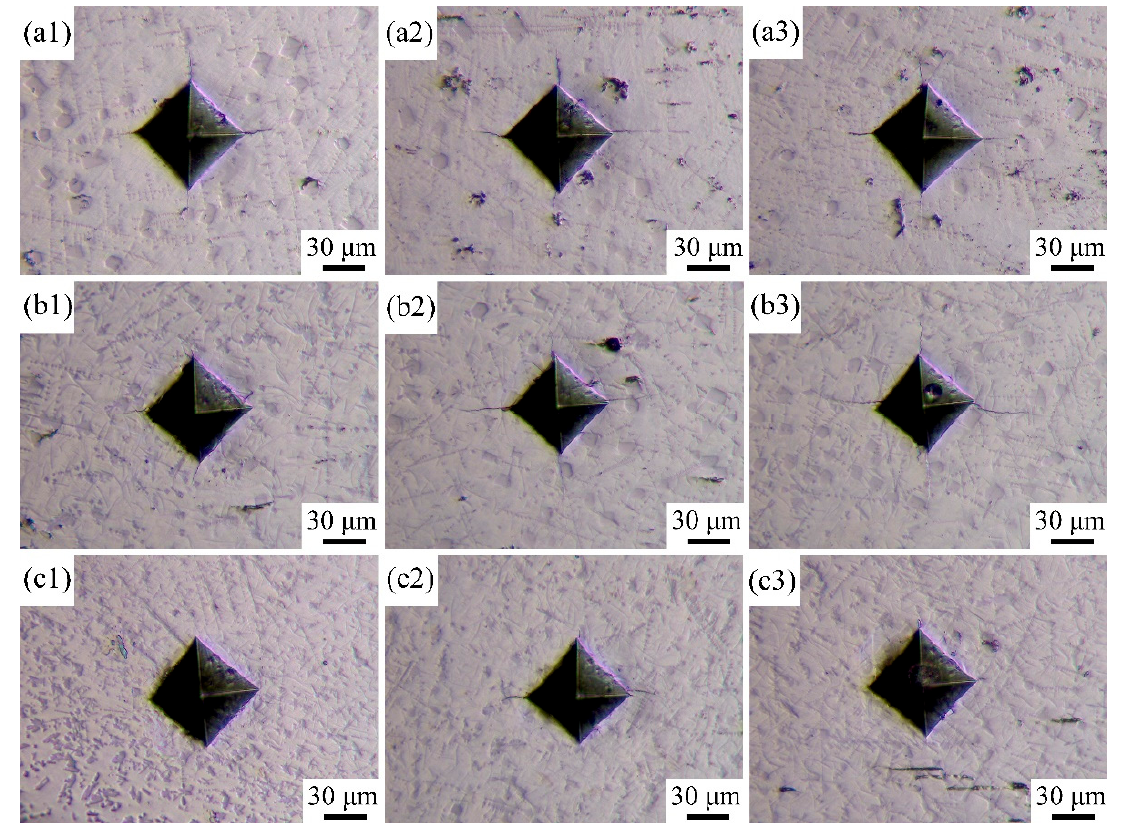
Figure 7. OM images of the indentations of the coatings: ( a1 – a3 ) Coating 1 for 5 mm ∙ s − 1 ; ( b1 – b3 ) Coating 2 for 11 mm ∙ s − 1 ; ( c1 – c3 ) Coating 3 for 17 mm ∙ s − 1 . Table 4. The fracture toughness of the coatings.